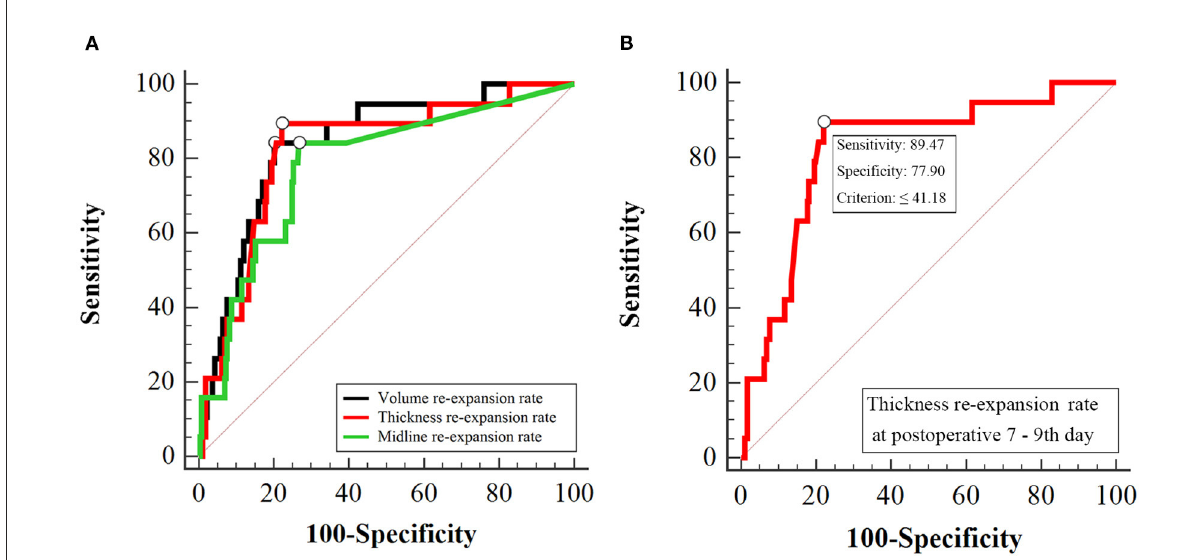
FIGURE2 Receiver operating characteristic curve analysis for postoperative brain re-expansion to predict CSDH recurrence. (A) Comparison of the three different of re-expansion at postoperative 7–9th day. The area under the curve of volume re-expansion rate, thickness re-expansion rate and midline re-expansion rate are 0.840, 0.823, 0.781, respectively ( p > 0.05). (B) Cut-off value of thickness re-expansion rate at postoperative 7–9th day. The cut-off value of the thickness re-expansion rate at postoperative 7–9th day is 41.18%, sensitivity is 89.47%, specificity is